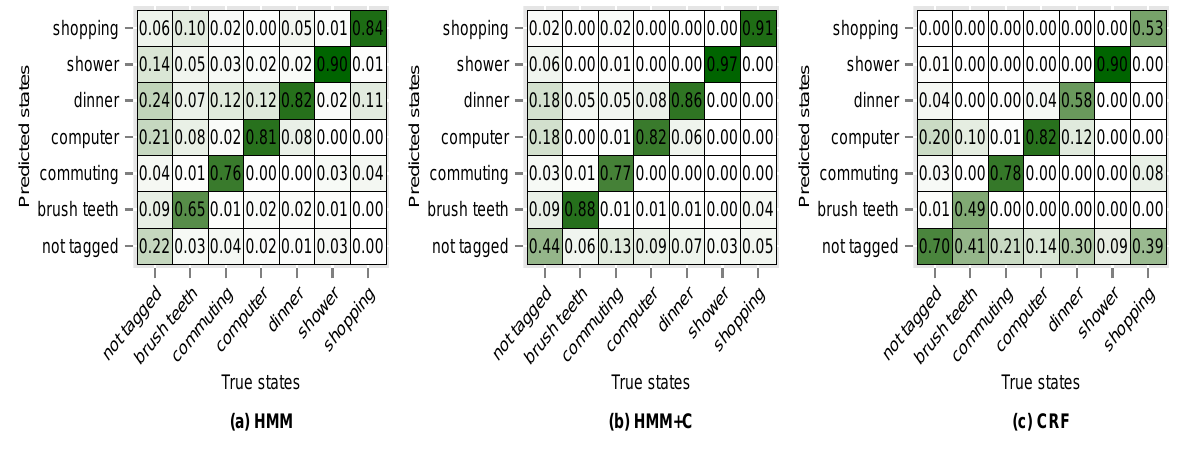
Figure 8. Confusion matrices for experiment 1 (subject 1): no